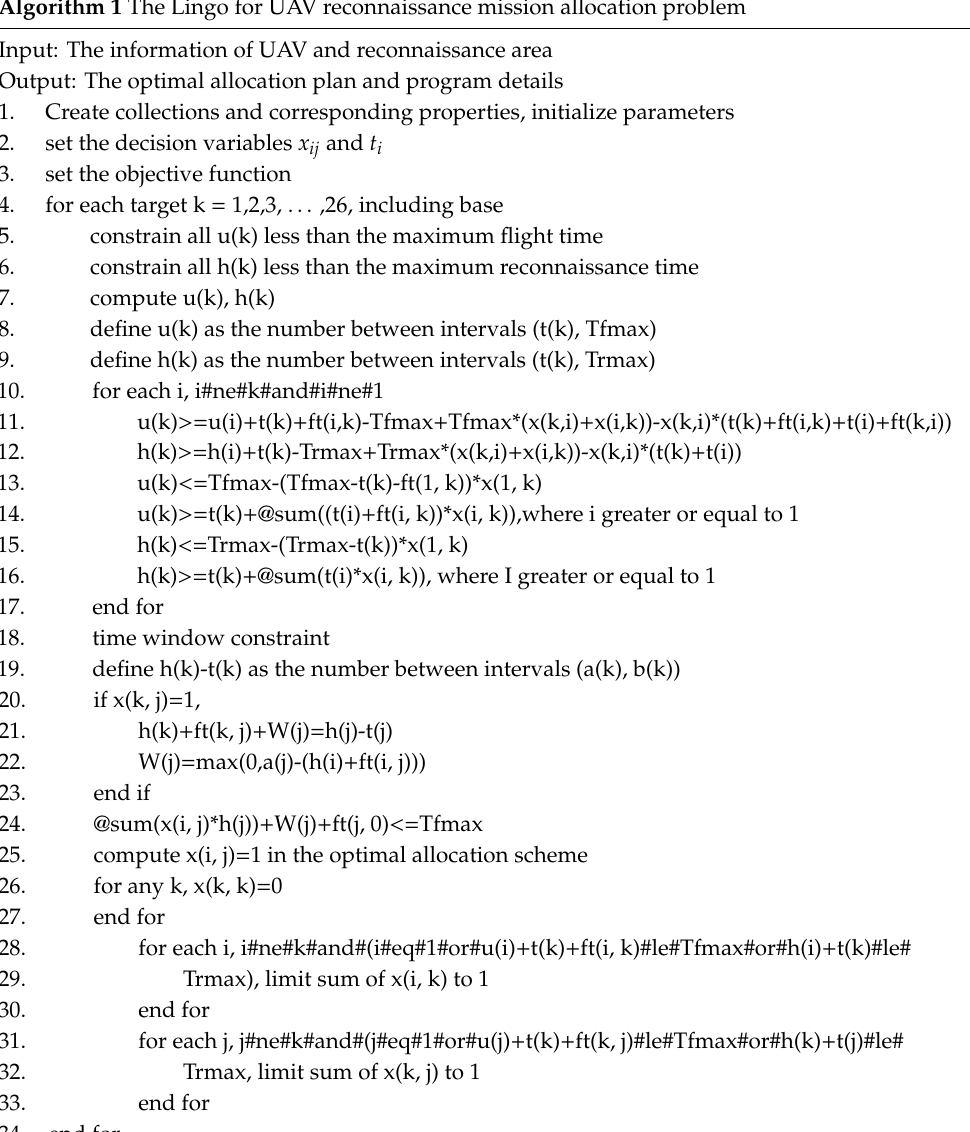
Algorithm 1 The Lingo for UAV reconnaissance mission allocation